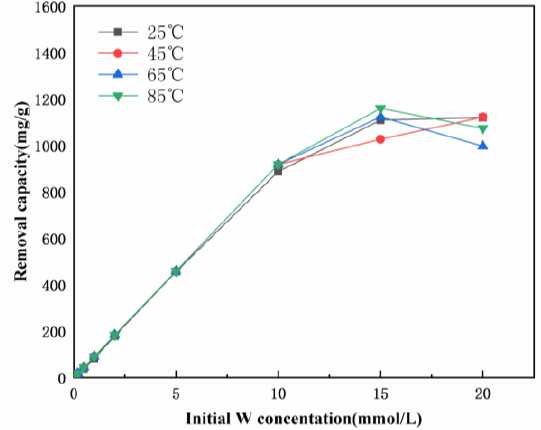
Figure 1. Tungsten uptake by hydrocalumite at 25, 45, 65, and 85